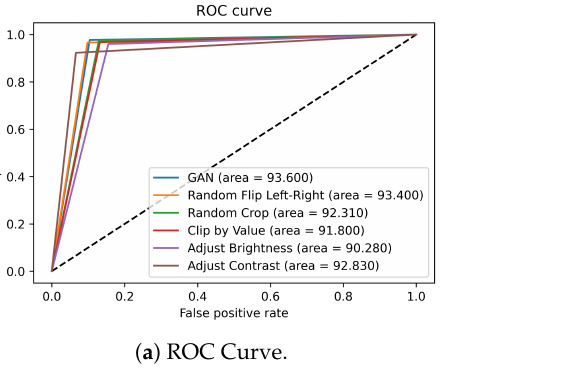
Figure 8. Receiver operating characteristics curve.